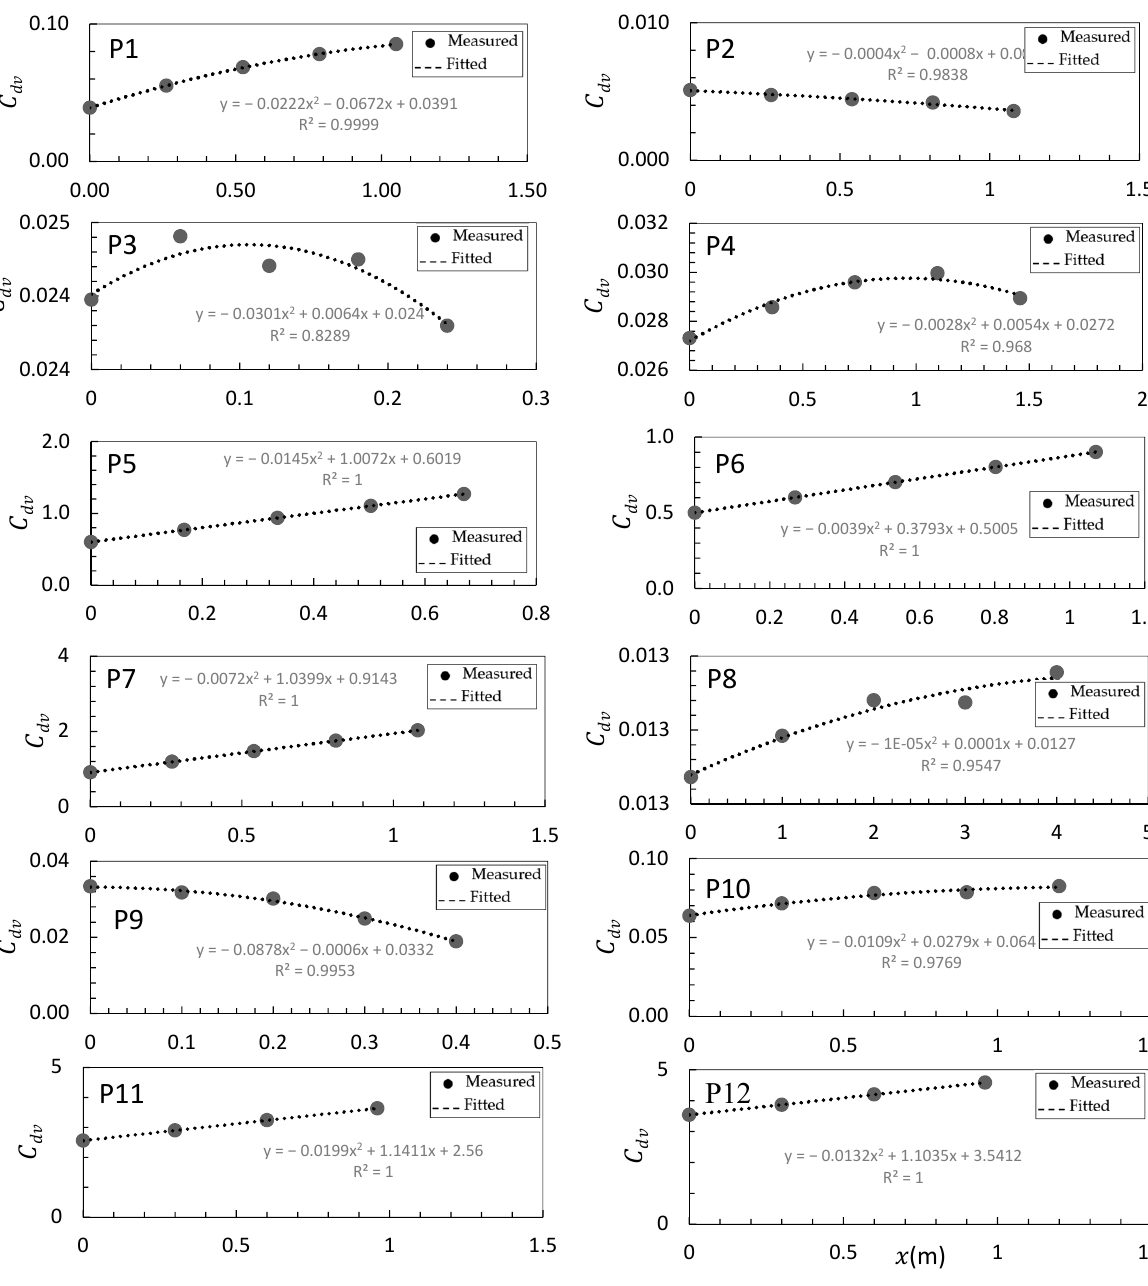
Figure 6. The streamwise variations in drag coefficient C dv of the flexible vegetation obtained from the field data for all vegetated patches.